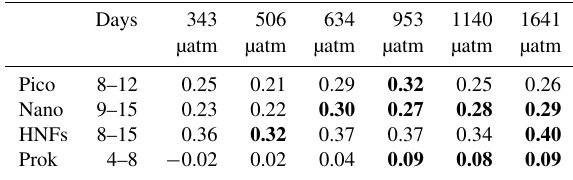
Bold text denotes treatments with trends in steady-state logarithmic growth significantly different to the control (343µatm, p< 0 . 05 ; shown in Table 3). Days: days from which the linear regression for growth rates was modelled (shown in Fig. S2); pico: picophytoplankton; nano: nanophytoplankton; HNFs: heterotrophic nanoflagellates; prok: